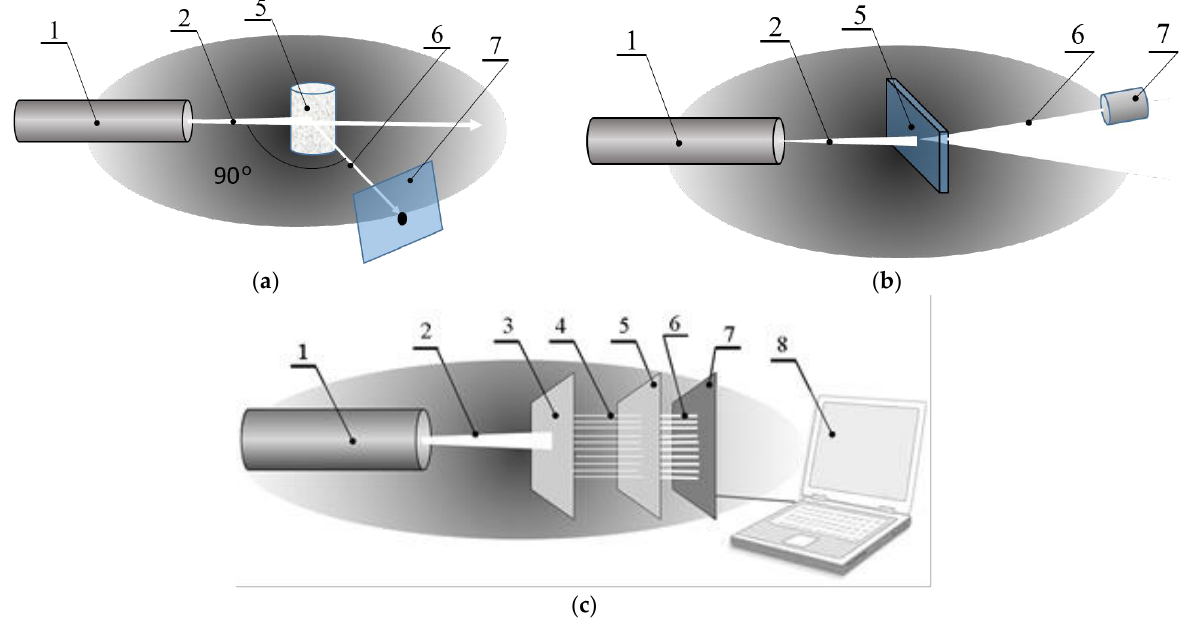
Figure 2. Schematic presentations of the LLS measurement setup: 90° scattering angle measurement, Scheme No. 1 ( a ); low-angle near-field speckle fluctuations capture, Scheme No. 2 ( b ); and multi-angle speckle fluctuation detection, Scheme No. 3 ( c ). 1—laser, λ = 645 nm; 2—laser beam; 3—collimator based on 2D diffraction grating; 4—multiple laser beam system; 5—multichannel chip; 6—a field of scattered light; 7 — multichannel diaphragm coupled with a photodetector device; and 8 — computer.